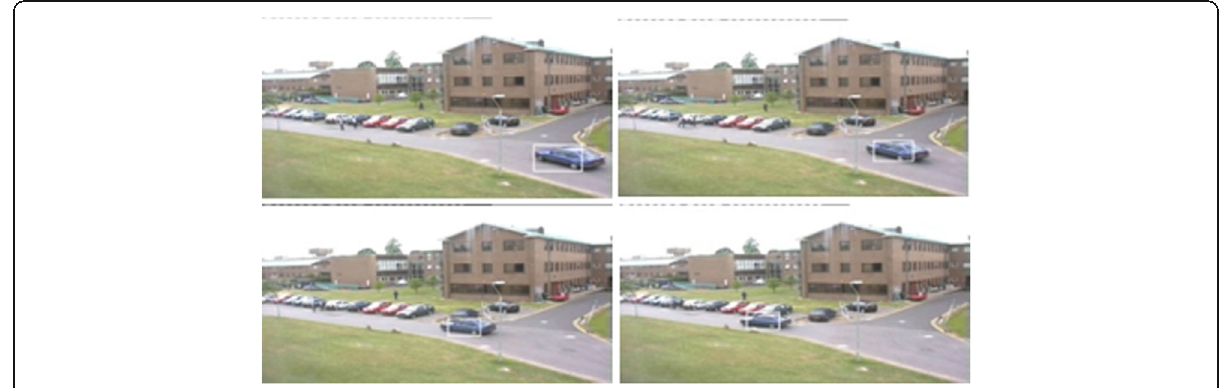
Fig. 24 Vehicle tracking results based on proposed algorithm under normal condition of image (images are from left to